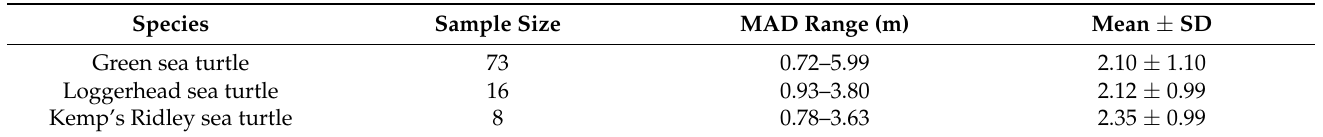
Table 2. Minimum Approach Distance (MAD) ranges, mean ± SD, for all species of sea turtles. SD = standard